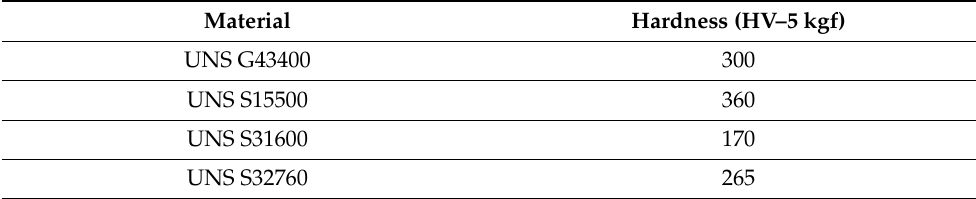
Table 2. Measured hardness of the tested